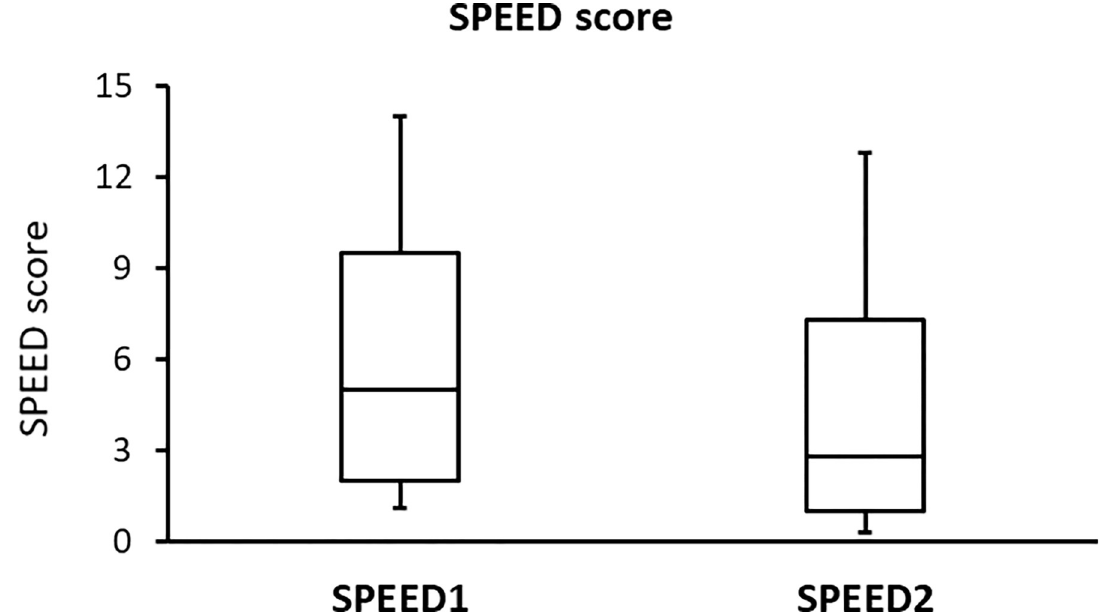
Fig 1. Side-by-side boxplots for the SPEED scores for the subjects with a high BMI before (SPEED1) and after (SPEED2) wearing a surgical face mask.